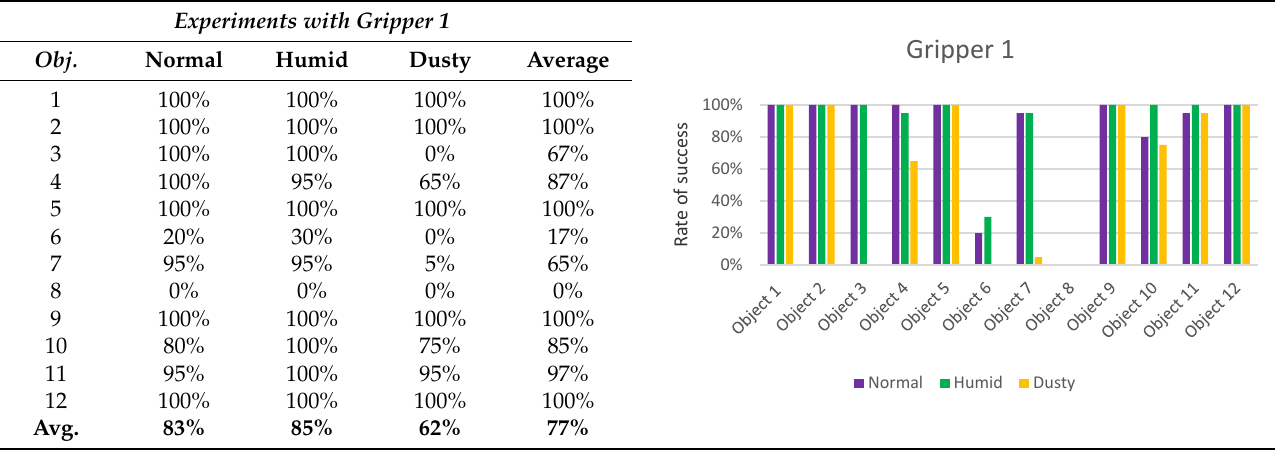
Table 2. Experiments with Gripper 1. On the left, the table with a success rate for every object, in the last column, the average for every object is calculated, and at the end of the table, the average success rate for every environment is deter- mined. On the right, the graphic representation of Table 2 is